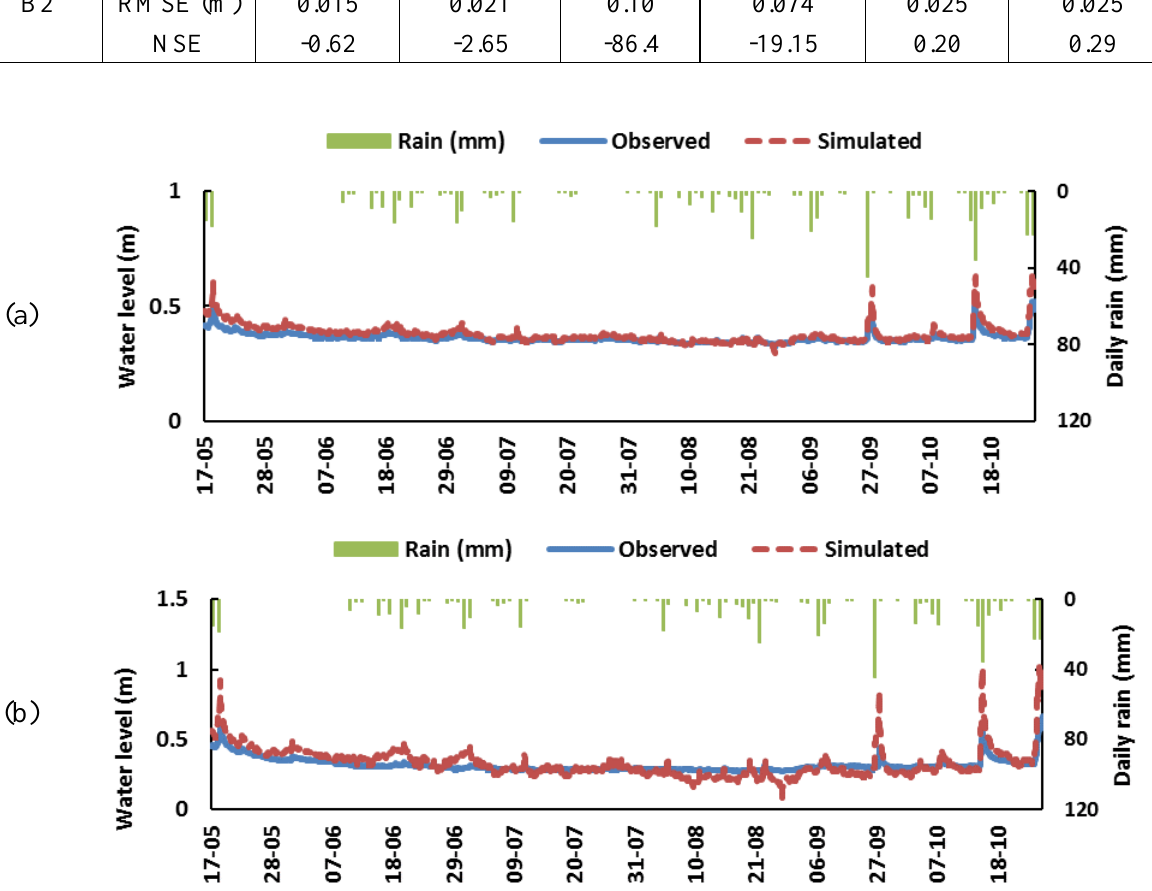
Figure 7. Time series (hourly) of observed and simulated water levels (a) upstream and (b) downstream of Basin